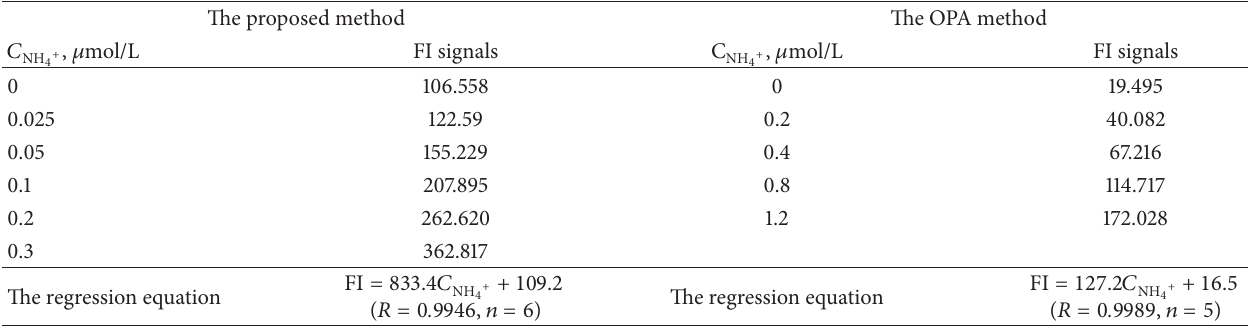
Table 2: The data of the calibration curves of the proposed method and the OPA method.